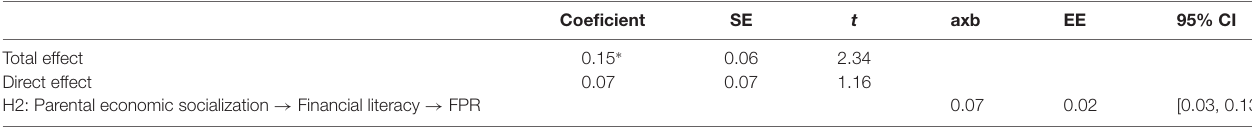
TABLE 3 | Regression results for testing mediation of financial literacy in the relationships between parental economic socialization and FPR.